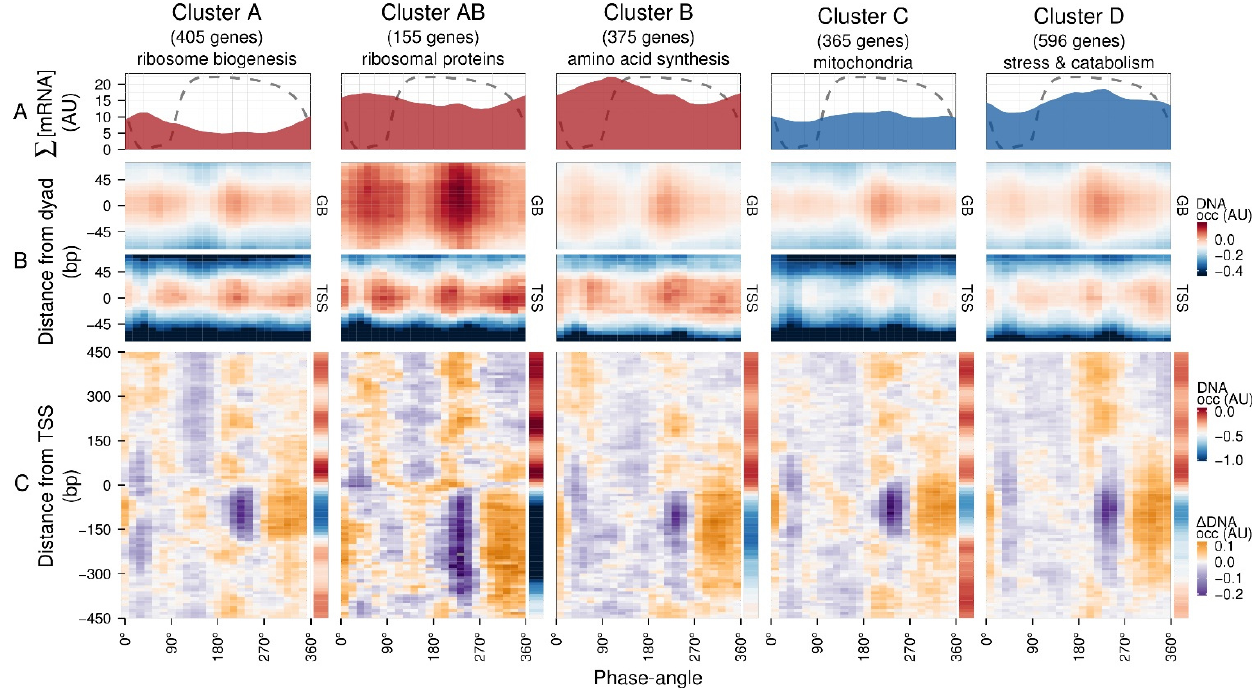
FIGURE 2: Expression dynamics of major gene clusters and the DNA occupancy dynamics at their average gene promoters during a respira- tory cycle . Messenger RNA abundances from the consensus clusters (Clusters A, AB, B, C and D; [19]) from a time-series microarray dataset [26] (48 samples; 4 min sampling, period 50 min) were summed for each cluster (A) , ∑[mRNA]. Transcripts that belong to the anabolic super- cluster (A, AB and B; produced during the oxidative phase) and those that belong to the catabolic supercluster (C and D; produced during the reductive phase) have a solid red and blue fill, respectively. The median DNA occupancy profiles of the aligned nucleosome dyads for the consensus clusters during a respiratory cycle ( (B) , DNA occ) were calculated as in Figure 1B. The DNA occupancy dynamics ( (C) , ΔDNA occ) were normalized by subtracting the log-ratio temporal average (red and blue side bar) from the median DNA occupancy for each expression cluster (see Fig. 1A). Dotted lines represent the residual dissolved oxygen (DO), scaled to the y-axis range of the panel. The transcript and nucleosome datasets were aligned using the minimum and maximum first derivative of the DO (Fig. S4A). The minimum first derivative of the DO data represents 0°/360°. The differential expression clusters B.C and B.D were merged into an expanded cluster B, as these were co- expressed during the short period oscillation. These clusters and lower signal-to-noise ratio clusters are shown in Figure